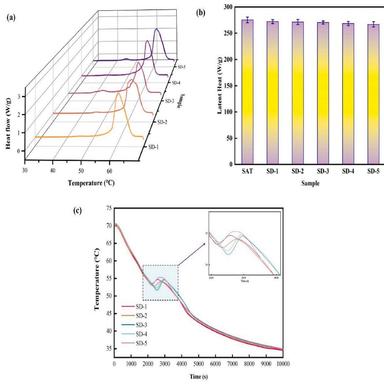
The phase change behavior of SD composite PCMs. (a) DSC curves; (b) latent heat of melting; (c) step cooling curves.